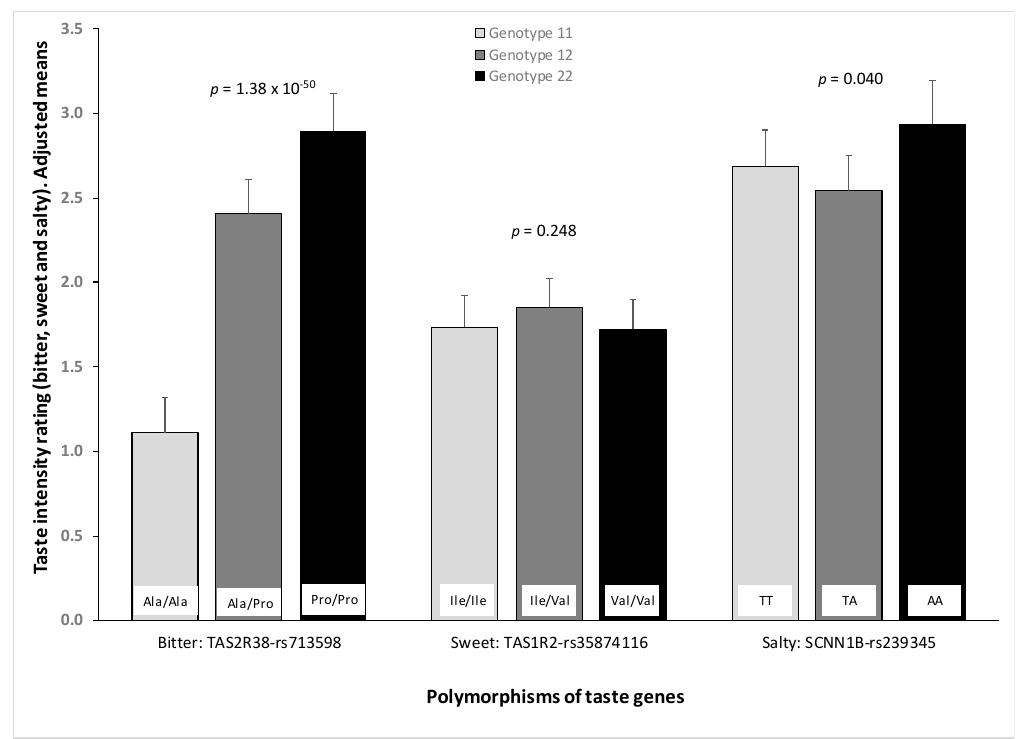
Figure 4. Taste perception (intensity rating) of bitter (PROP, 5.5 mM), sweet (sucrose, 400 mM) and salty (NaCl, 200 mM) in the whole population depending on the genotype for the corresponding taste polymorphism: TAS2R38-rs713598 for bitter (PROP); TAS1R2-rs35874116 for sweet; and SCNN1B-rs239345 for salty. Means were adjusted for sex, age, diabetes, body mass index, smoking and medications (model 3). p -values show the statistical significance for the corresponding taste polymorphism (3 genotypes as codominant) in the multivariate adjusted model 3. n = 945 for TAS2R38-rs713598; n = 949 for TAS1R2-rs35874116; and n = 927 for SCNN1B-rs239345. Error bars are